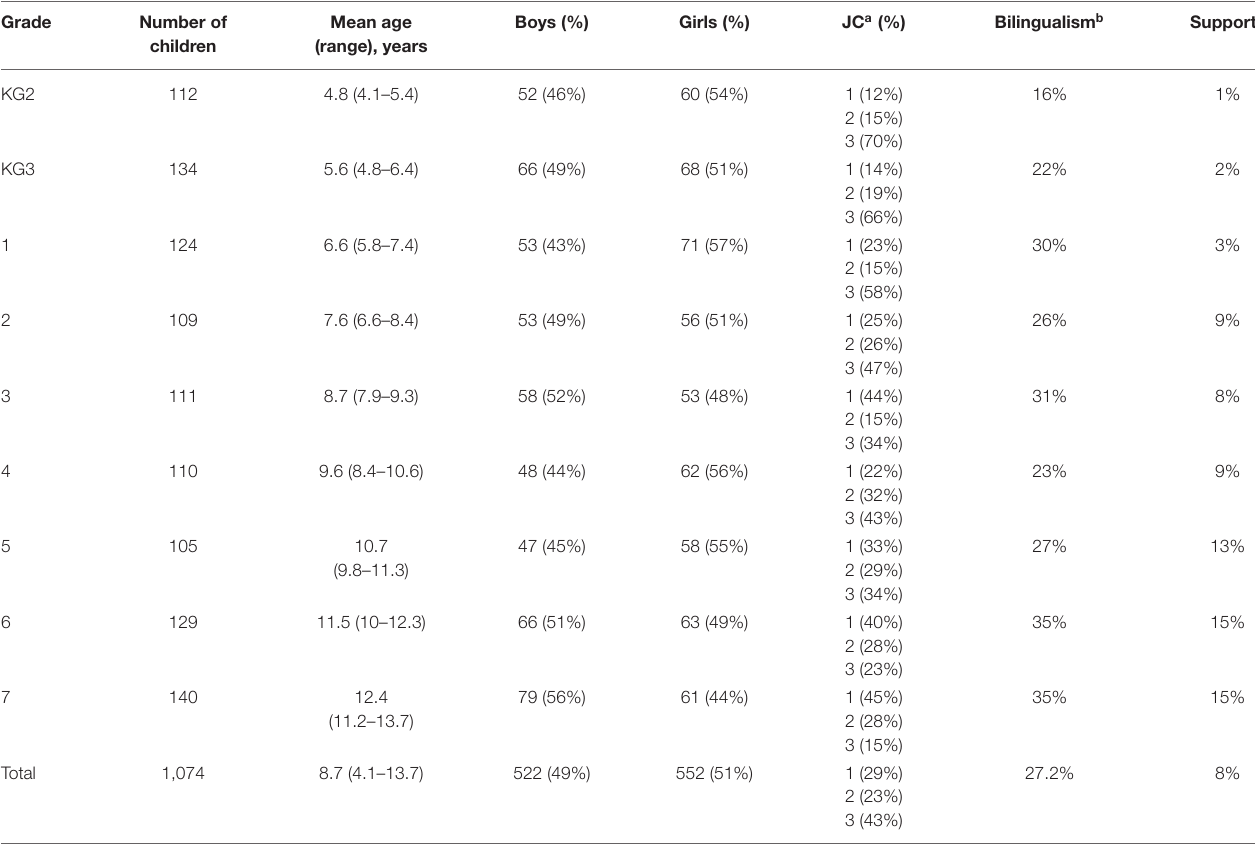
TABLE 2 | Characteristics of normative